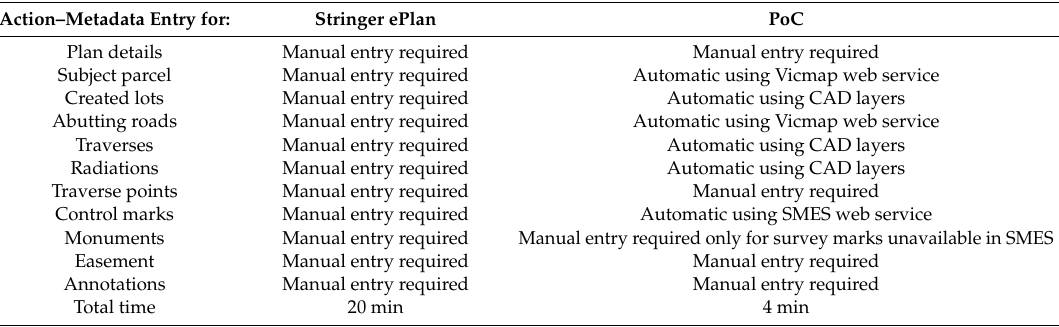
Table 3. ePlan creation approach in Stringer ePlan vs. newly developed approach in